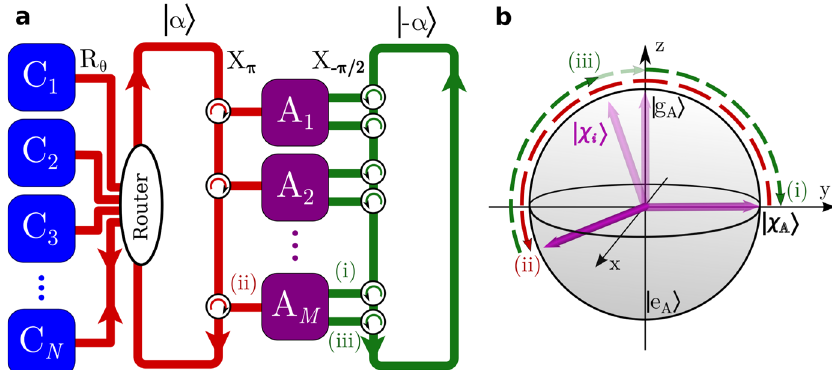
Fig. 3 a Schematic diagram of the drive-refreshing protocol. During a single cycle, the itinerant drive pulse ( red ) induces a chosen rotation R θ on one of the qubits C i in the register and is then refreshed by sequential X π interactions with each ancillary qubit {A j }. In an ideal setting, each ancilla is prepared precisely into the state ð g ground states and their imperfect preparation and reset is implemented by an itinerant corrector pulse ( green ). b Evolution of an ancilla state during a refreshing cycle: (i) preparation from the ground state into the state χ rotation ( red ), and (iii) ancilla reset. We either assume that the preparative steps (i) and (iii) are ideal or induced by a corrector